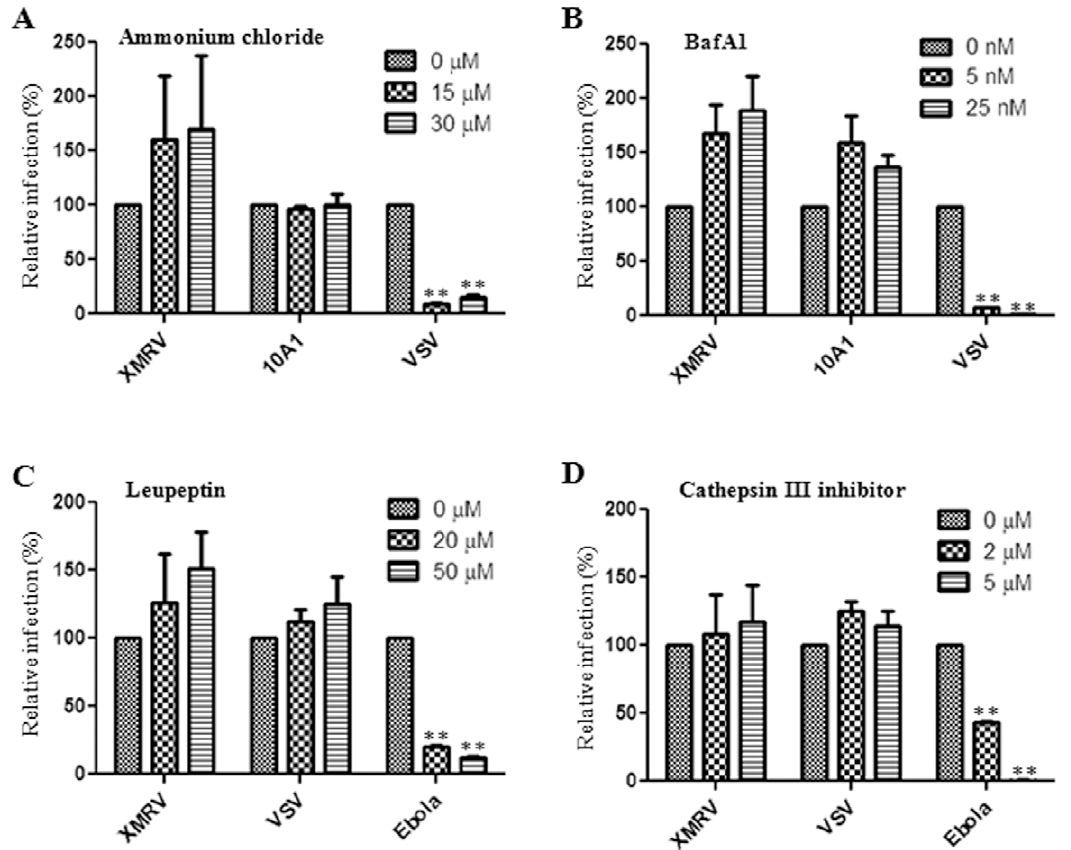
Figure 1. XMRV entry is pH-independent and does not require host proteases. HTX cells were pre-treated with indicated concentrations of (A) ammonium chloride, (B) Bafilomycin A1 (BafA1), (C) leupeptin or (D) cathepsin III inhibitor for 1 h and infected with MoMLV pseudotypes encoding GFP and bearing XMRV Env, MLV 10A1 Env, VSV-G or Ebola GP in the presence of drugs for 6 h before inactivation of remaining virions using citrate buffer. Percentage of GFP-expressing cells was measured by flow cytometry 48 h post-infection and normalized to the infection obtained in the absence of drug set to 100%. Shown are at least the averages of 3 independent experiments 6 S.D. ** indicates p , 0.01.